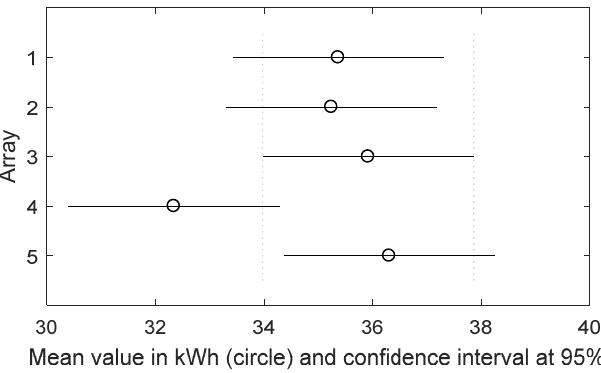
Figure 11. Mean value of the energy produced by each array for the one-year analysis. Table 8. One-to-one comparison of the means for the one-year analysis. Comparison between Samples